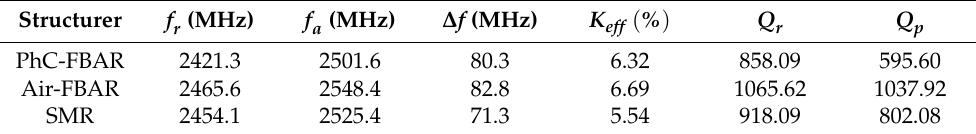
Figure 11. Comparison of impedance spectra of three kinds of acoustic isolation structures with the same piezoelectric stack. Table 3. Performance characteristics of FBARs with different